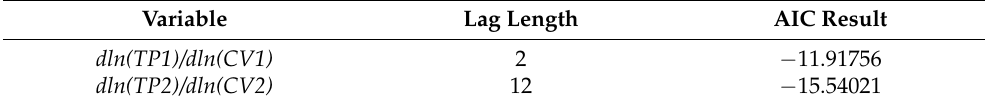
Table 3. Result of AIC